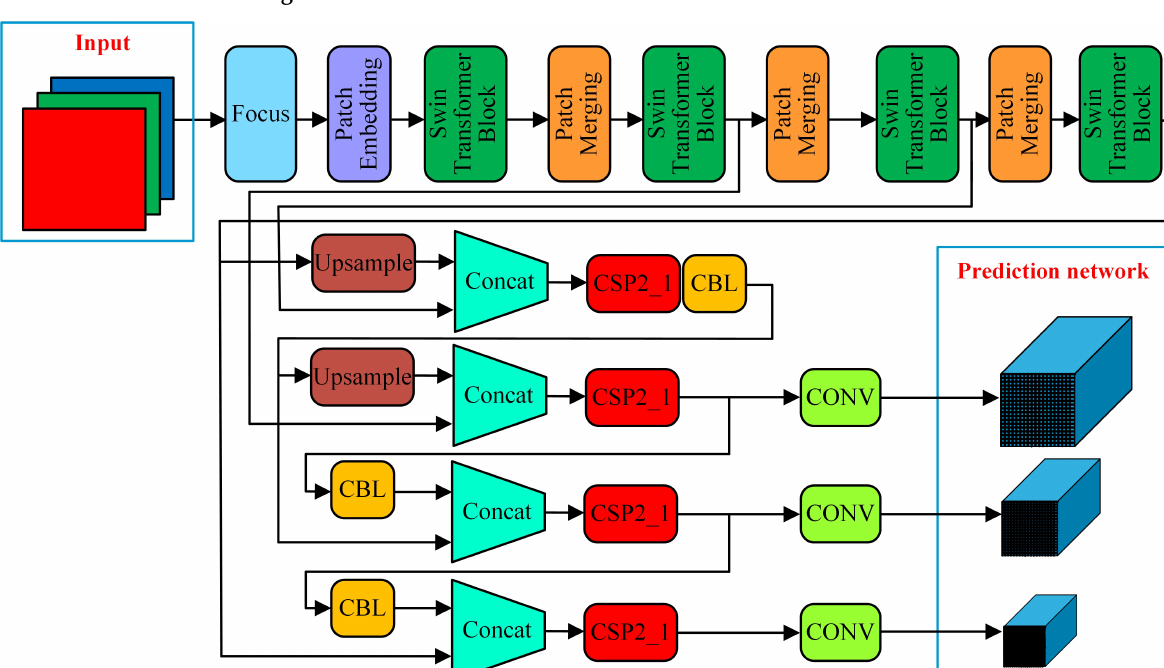
Figure 5. The structure of YOLOv5 using Swin Transformer as the backbone